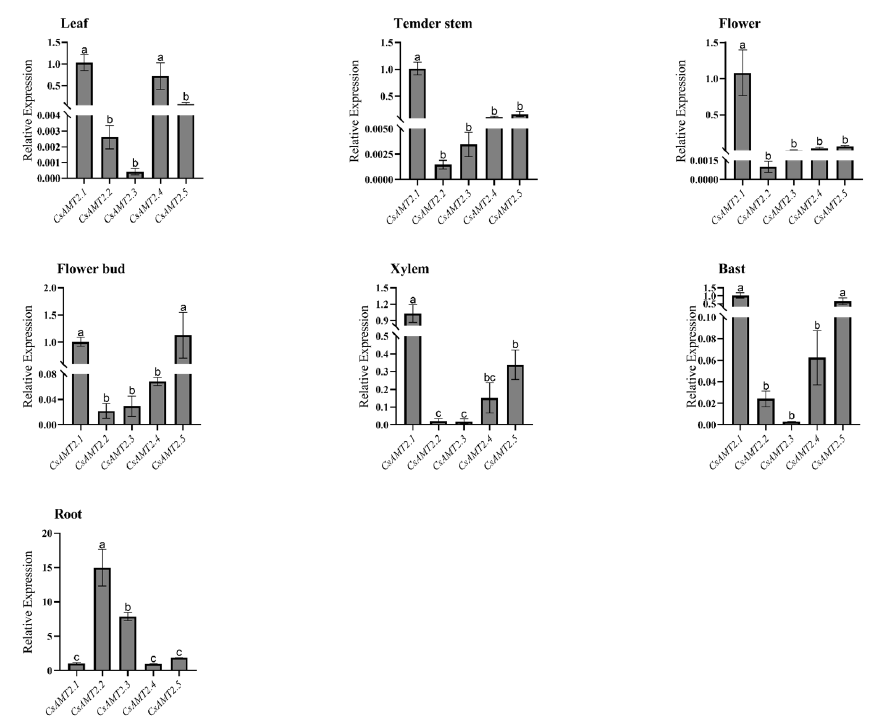
Figure 5. The expression of different CsAMT2 genes in the same tissue of FD. Expressions of CsAMT2.1 in FD were used as the control in the comparison of each tissue. The lowercase letters represent significant differences at p < 0.05 by using one-way analysis of variance (ANOVA) by Duncan. Three biological replicates and three technological replicates were performed for each tissue.